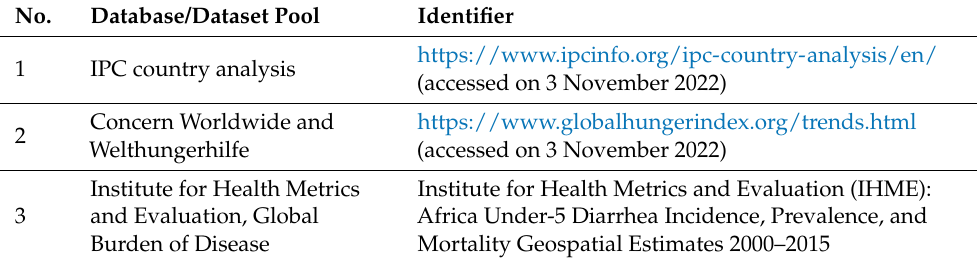
Table 1. Database/dataset pools and